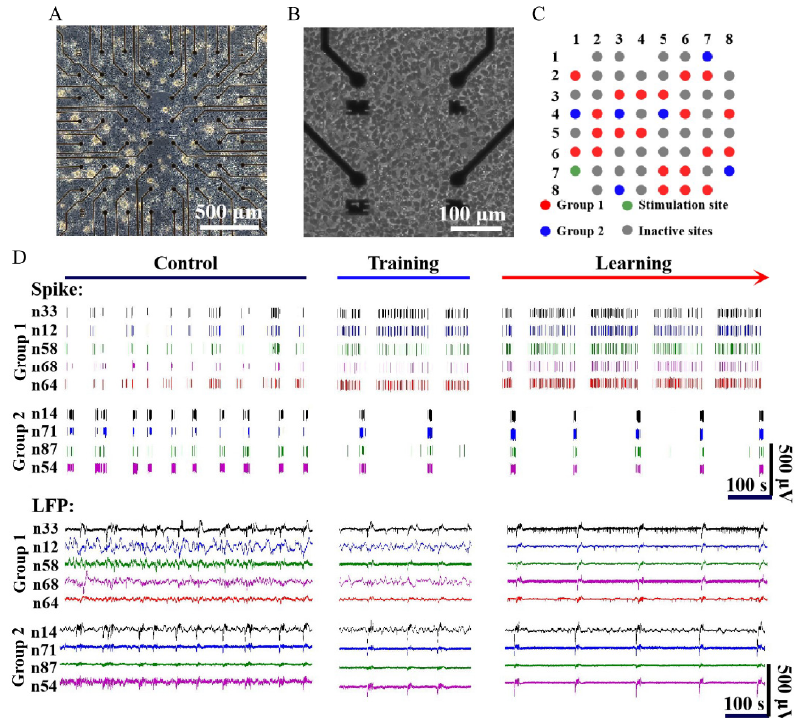
Figure 5. Electrophysiology signals from the dissociated hippocampal culture before and after learning training. ( A ) Morphology of hippocampal neurons cultured for 1 week in vitro. ( B ) The neurons on the electrodes in ( A ) at higher magnifications. ( C ) The distribution and proportion of electrodes recording neuronal activities in Group 1 (red), electrodes recording neuronal activities in Group 2 (blue), inactive electrodes (gray), and stimulating electrodes (green). ( D ) Spikes and LFPs recorded by the neural sensor before and after training.